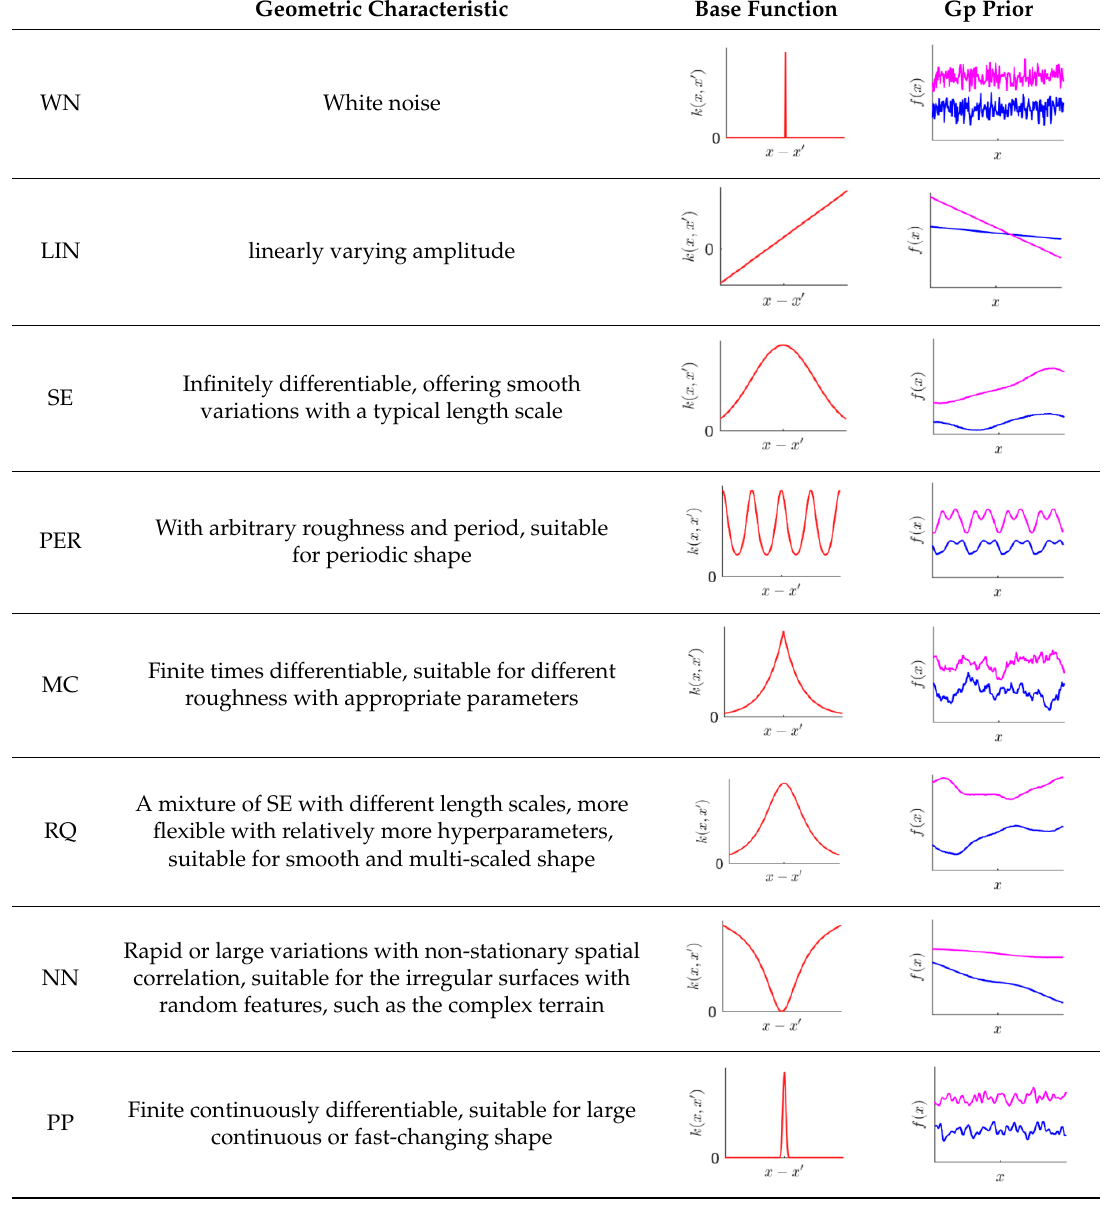
Figure 3. Design of composite covariance kernel functions. Table 1. Geometric characteristics of 8 base kernel functions.